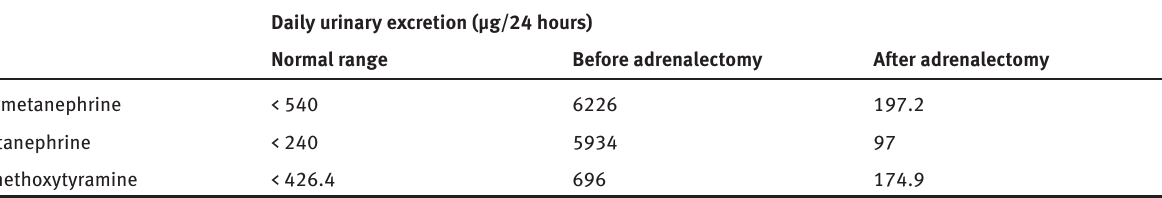
Table 1: Urinary excretion of methylated catecholamines before and 6 months after adrenalectomy in a patient with pheochromocytoma Daily urinary excretion (μg/24 hours) Normal